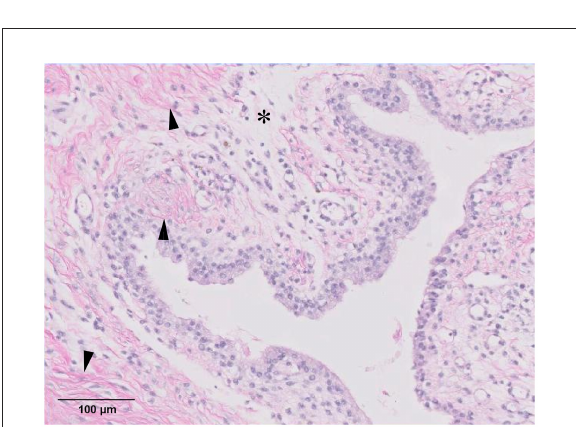
FIGURE5 Biopsy results. Synovium with adjacent fibrous connective tissue, adipose tissue, and vasculature. Moderate fibrosis (arrowhead) is noted, and moderately edematous lesions (asterisk) are identified (magnification × 20, haematoxylin and eosin